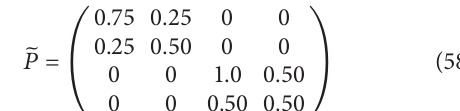
Figure 8: The evolution of velocity states V 𝑖 (𝑡) for 𝑖 = 0, 1, .. . ,4 . ̃𝑃𝐻+𝐻 𝑇 ̃𝑃 = 𝐼 equation 4 and has the positive definite solution as